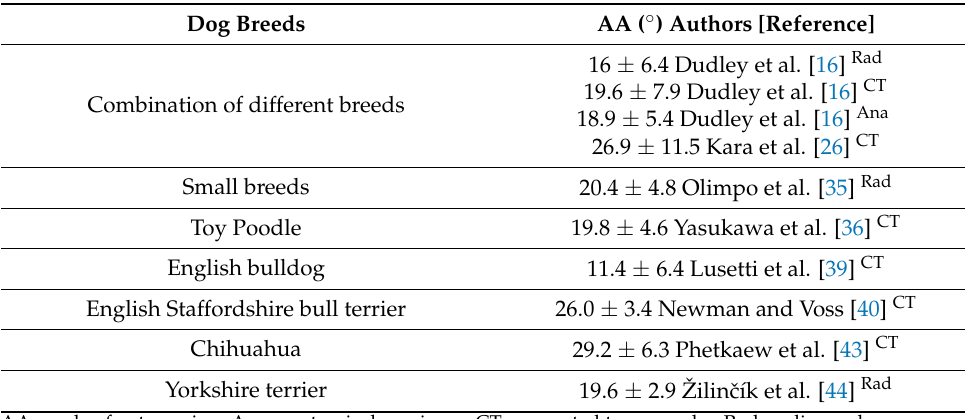
Table 12. Mean ± standard deviation of the AA in healthy dogs.